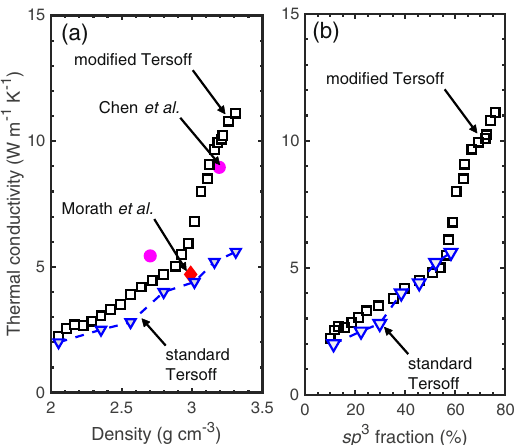
Fig. 2 Thermal conductivity of amorphous carbon. Green-Kubo predicted thermal conductivities of our amorphous carbon domains described by the standard and modi fi ed Tersoff potentials at different a mass densities and b sp 3 content. For comparison, we also include the experimental results from Chen et al. 18 and Morath et al. 13 at the reported densities. While the modi fi ed Tersoff potential predicts a higher increase in thermal conductivity at relatively higher mass densities (>2.8 g cm − 3 ), the thermal con- ductivity of our amorphous carbon structures described by the two potentials are similar when compared to their respective sp 3 concentrations. This suggests that carbon hybridization has a signi fi cant role in dictating the thermal conductivity of amorphous carbon.